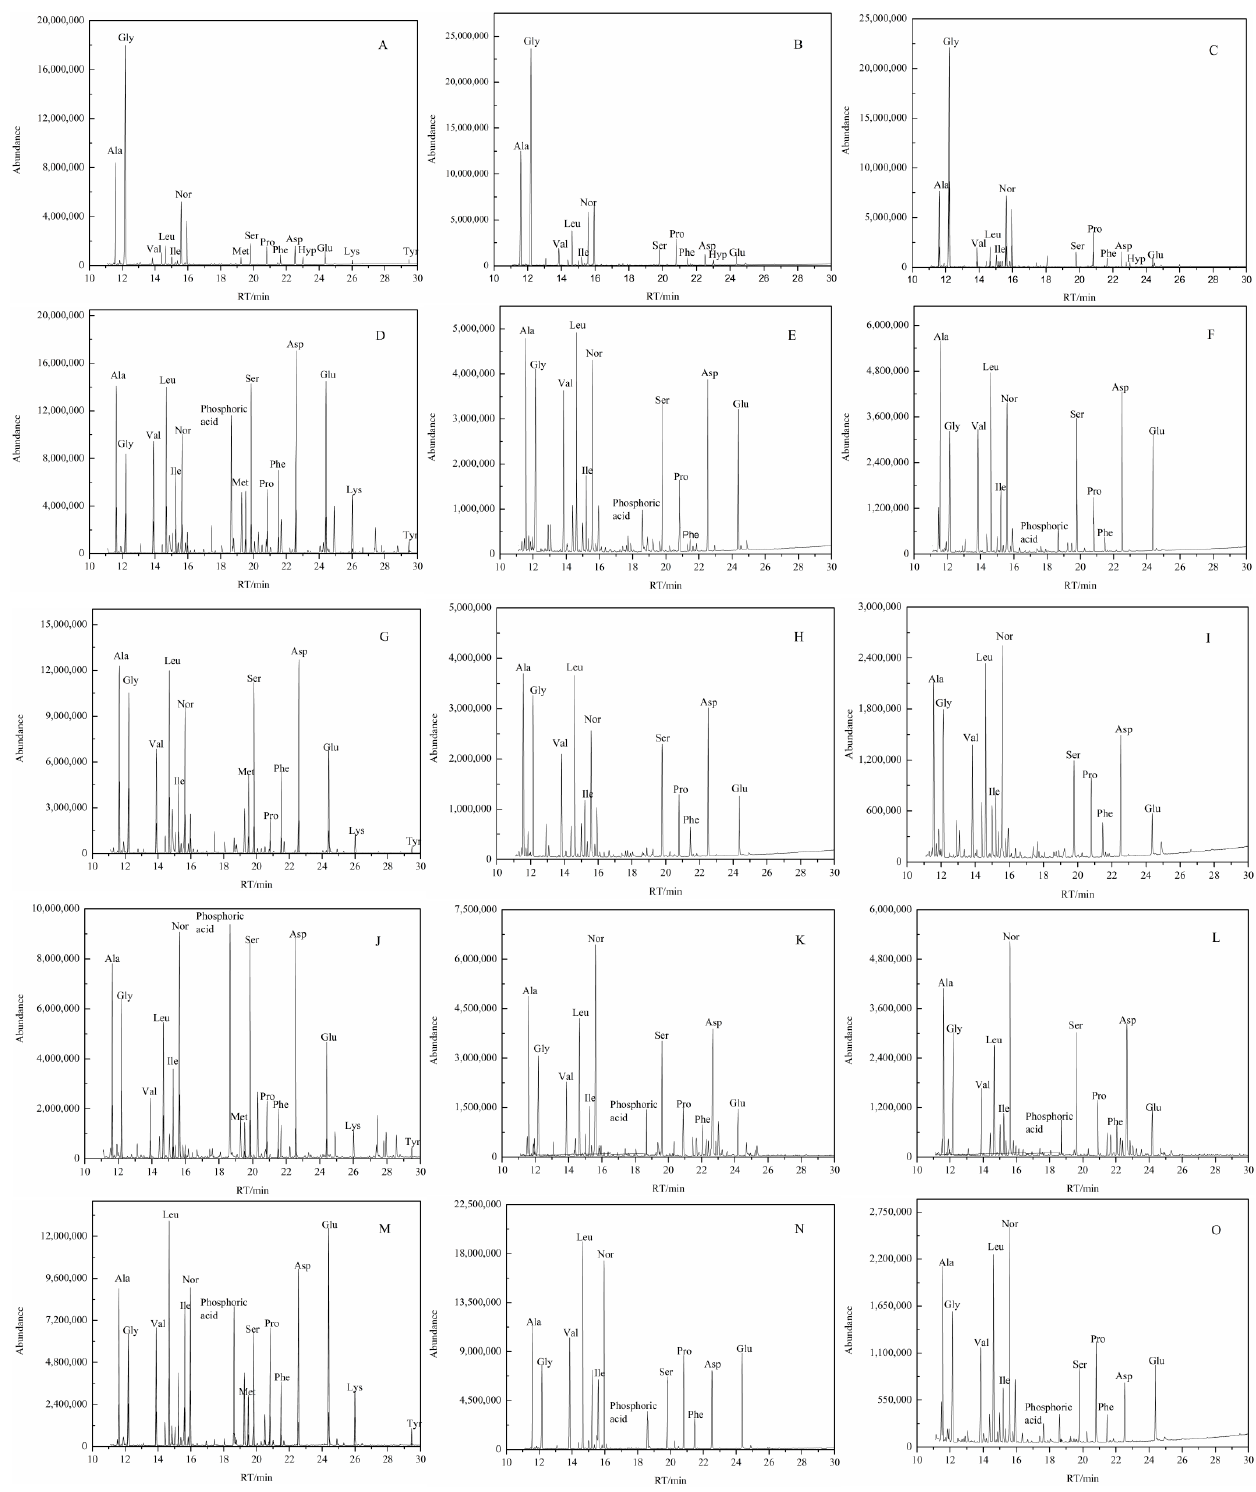
Figure 1. Chromatograms of the five fresh, natural-aged binders (( A ) fresh pig glu-FPG, ( B ) aged pig glue-APG, ( C ) aged pig glue with ultramarine-APGU,( D ): fresh whole egg-FWE, ( E ): aged whole egg-AWE, ( F ): aged whole egg with ultramarine-AWEU, ( G ): fresh egg white-FEW, ( H ): aged egg white-AEW, ( I ): aged egg white with ultramarine-AEWU, ( J ): fresh egg yolk-FEY, ( K ): aged egg yolk-AEY, ( L ): aged egg yolk with ultramarine-AEYU, ( M ): fresh casein-FC, ( N ): aged casein-AC, ( O ): aged casein with ultramarine-ACU).